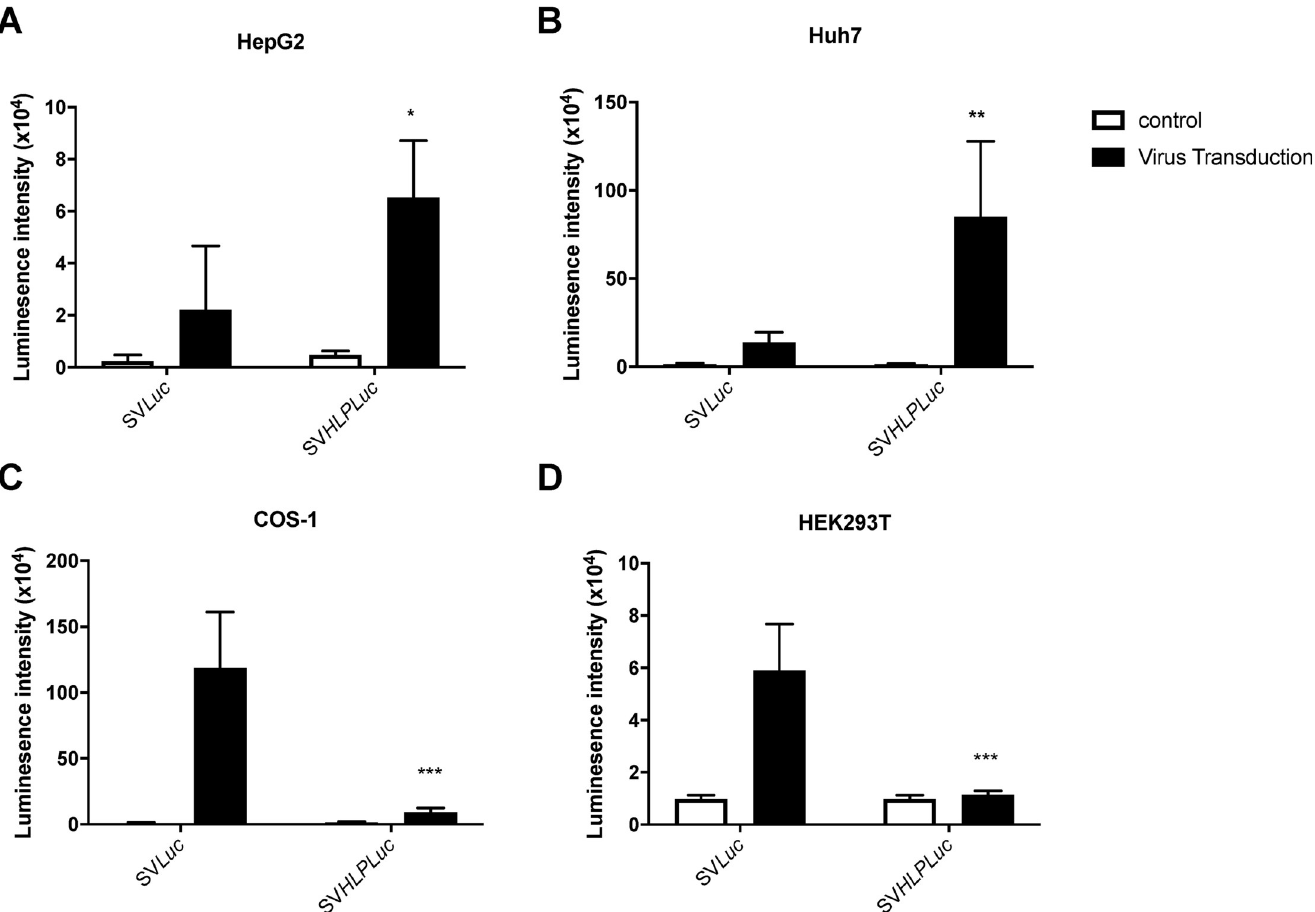
Fig 2. Insertion of a liver specific promoter in rSV40 vectors enhances specific expression of reporter gene. 400 vg/cell of rSV40- Luc or rSV40-HLP- Luc were added to 10 4 cells of HepG2 (A), Huh7 (B), COS-1 (C), or HEK293T (D) in a well of a 96 well plate (n = 3). After 2–5 days the luciferase expression was quantified by measuring the luminescence using the synergy HT machine. � p < 0.05, �� p < 0.01, ��� p < 0.001. Data represent the mean ± SD. Statistical significance was determined by Two-way ANOVA